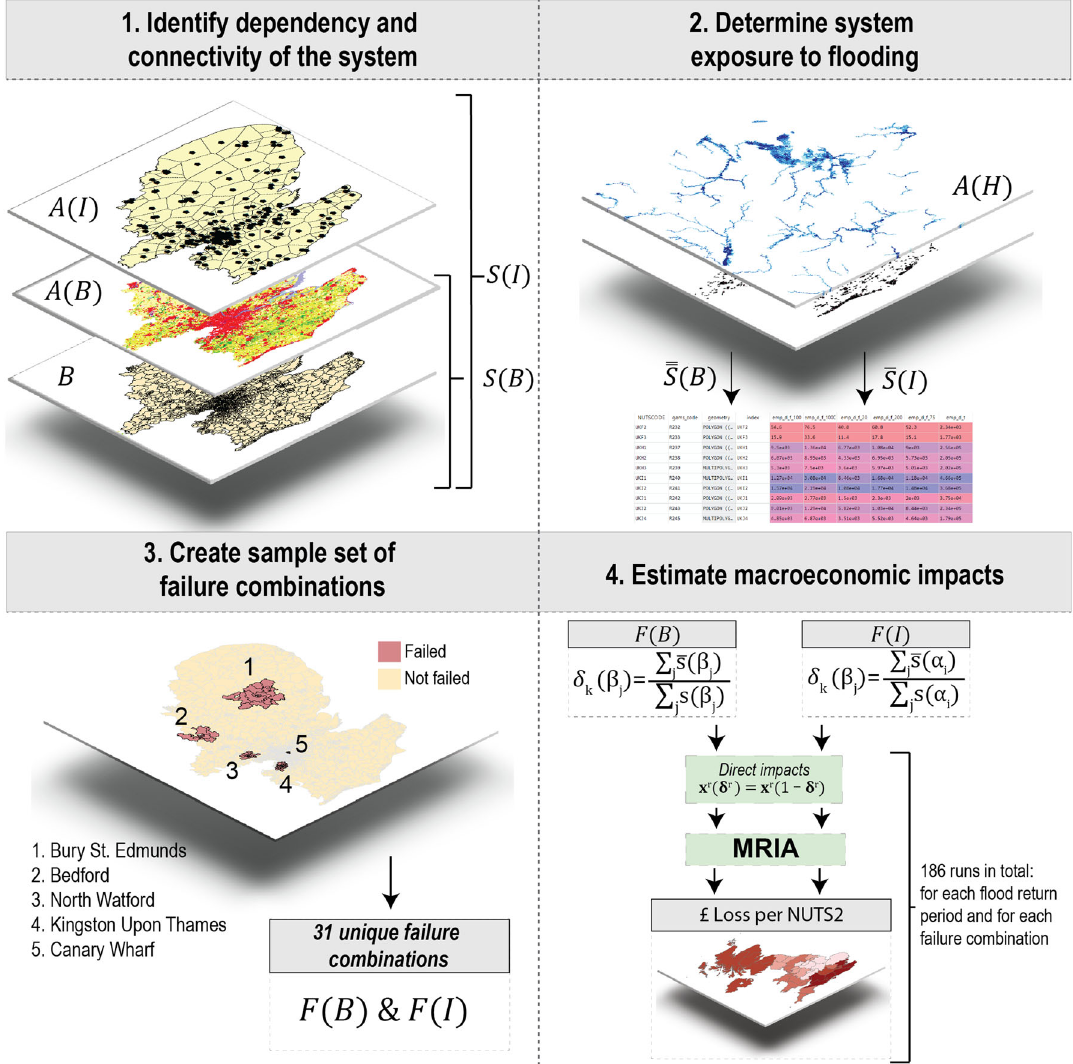
Fig. 3 Presentation of the application of the Middle Layer Super Output Area (MSOA) general framework to the United